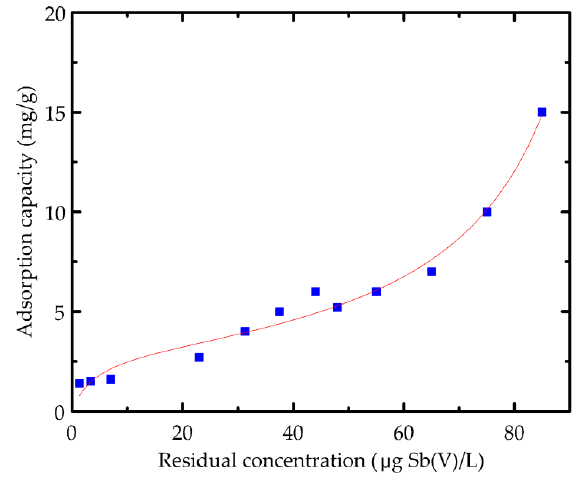
Figure 4. Fitting of Sb(V) adsorption onto FeOOH precipitates (BET model) by using coagulation/ precipitation with Fe(III); experimental conditions: pH 7, T = 22 ± 1 °C, initial concentrations range 15 –100 μg Sb(V)/L, Fe(III) dose range 1– 10 mg/L. Table 3. BET fitting parameters for Sb(V) adsorption isotherms at pH 7 (according to the equation: Q = aC/(1 + bC + dC 2 )).